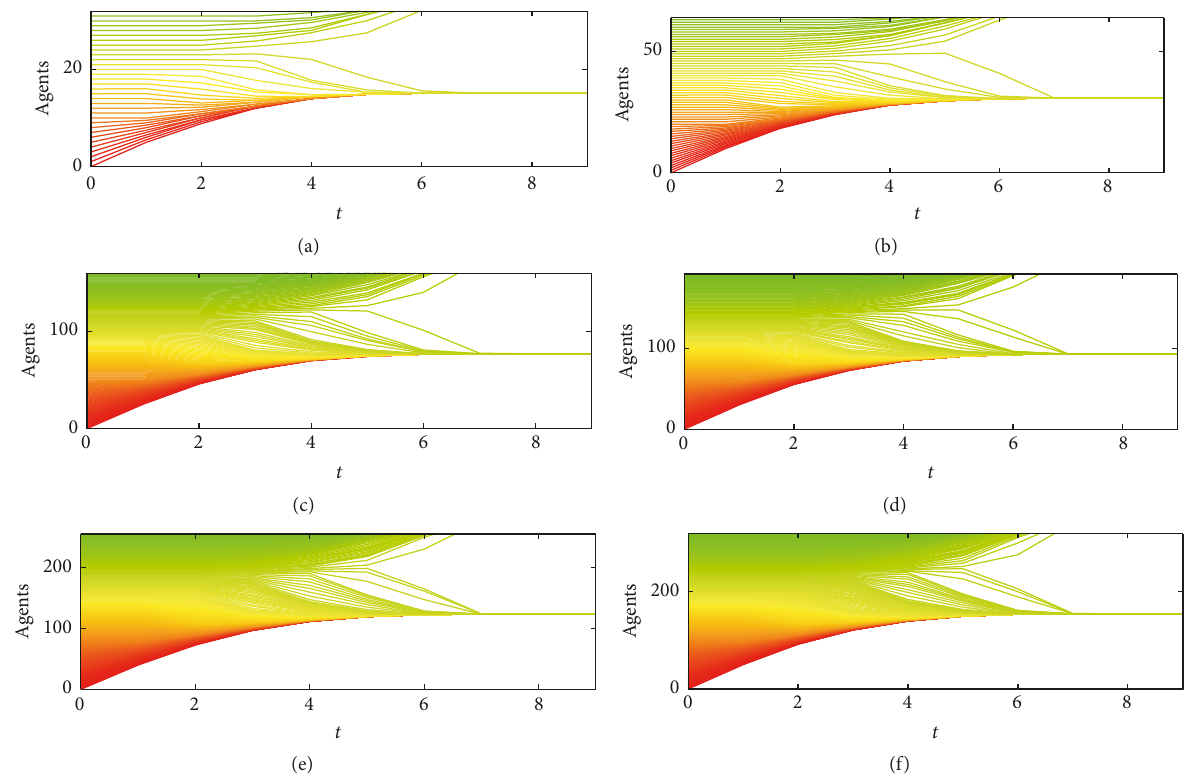
Figure 3: Opinion evolution in our constructed BA scale-free network: in each plot, the 𝑥 -axis is time and the 𝑦 -axis represents the nodes. ( a ) → ( f ) describe opinion evolution with different numbers of agents.